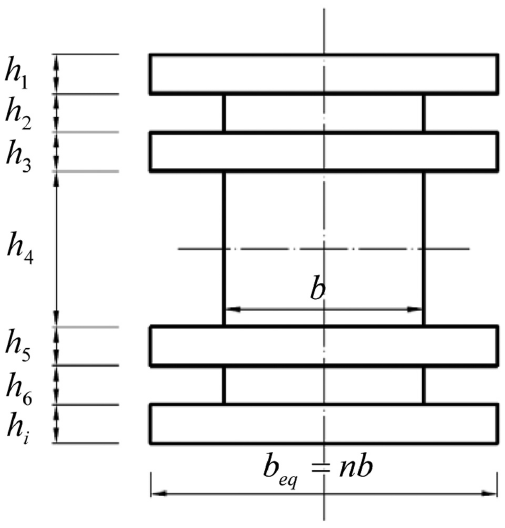
Fig. 5. Equivalent cross section of the composite